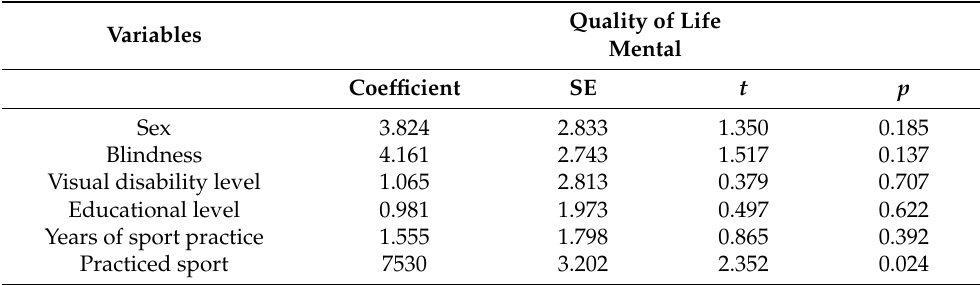
Table 5. Multiple linear regression analysis of characteristics of visually impaired athletes to predict mental quality of